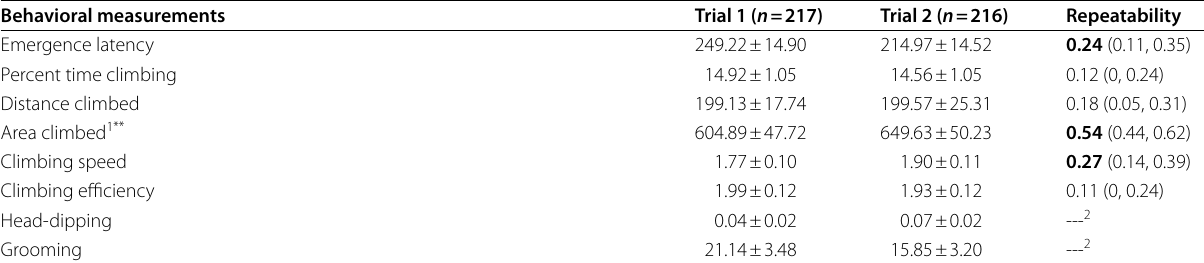
Table 1 Mean (± SE ) behavioral performances and behavioral repeatability (assessed by R value with 95% CI in parenthesis) of eastern bent-wing bats in hole-board box tests.